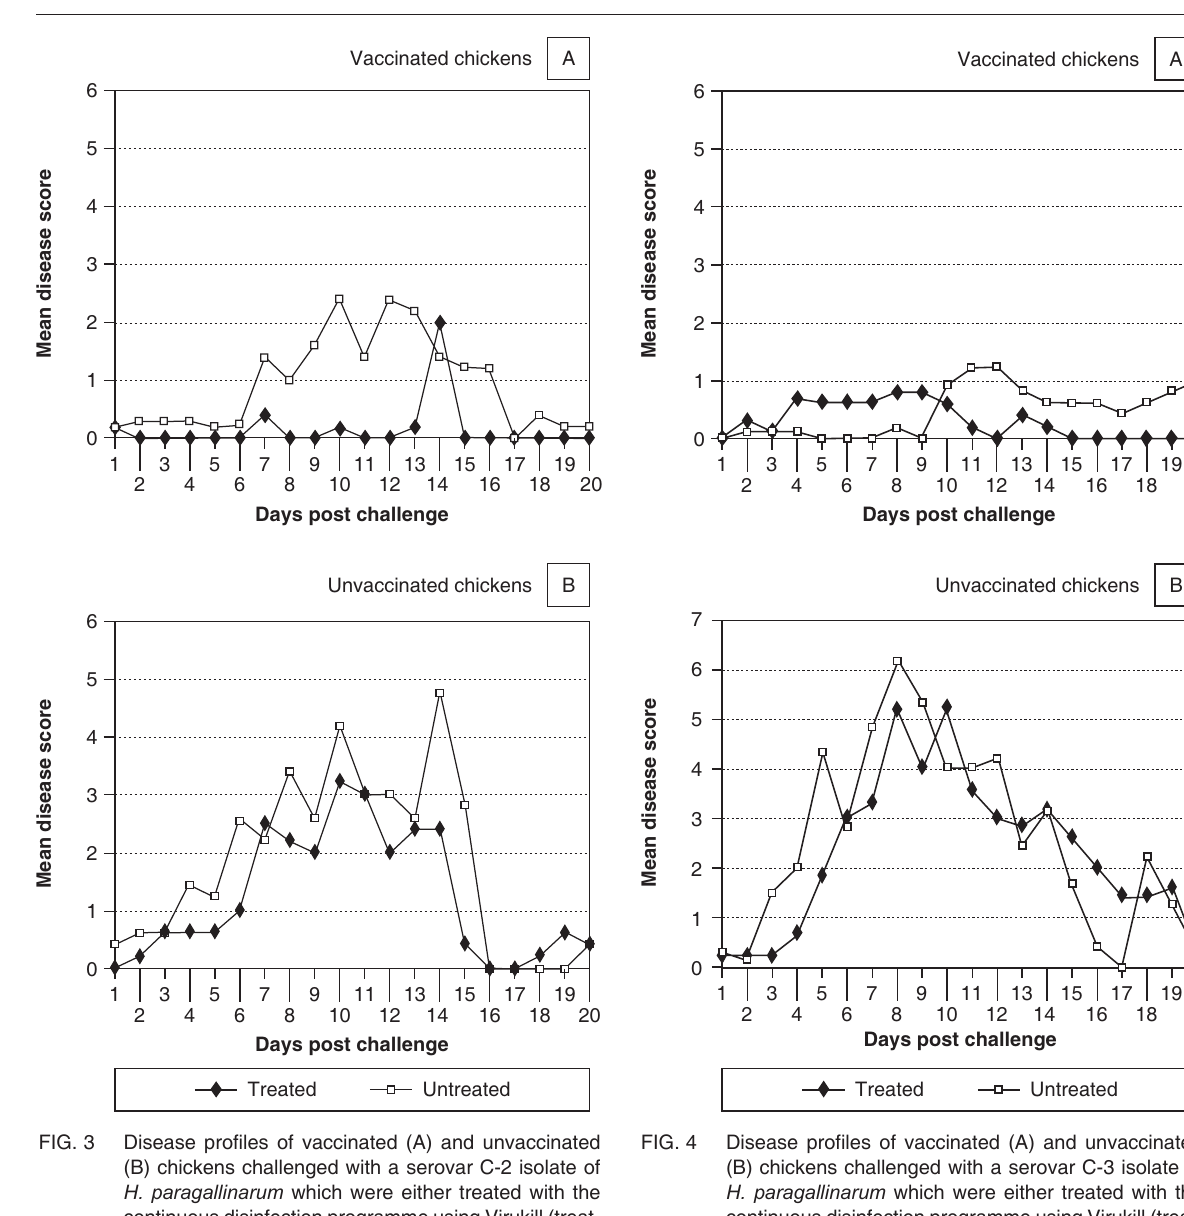
FIG. 3 Disease profiles of vaccinated (A) and unvaccinated (B) chickens challenged with a serovar C-2 isolate of H. paragallinarum which were either treated with the continuous disinfection programme using Virukill (treat- ed) or not treated in any other way (untreated)